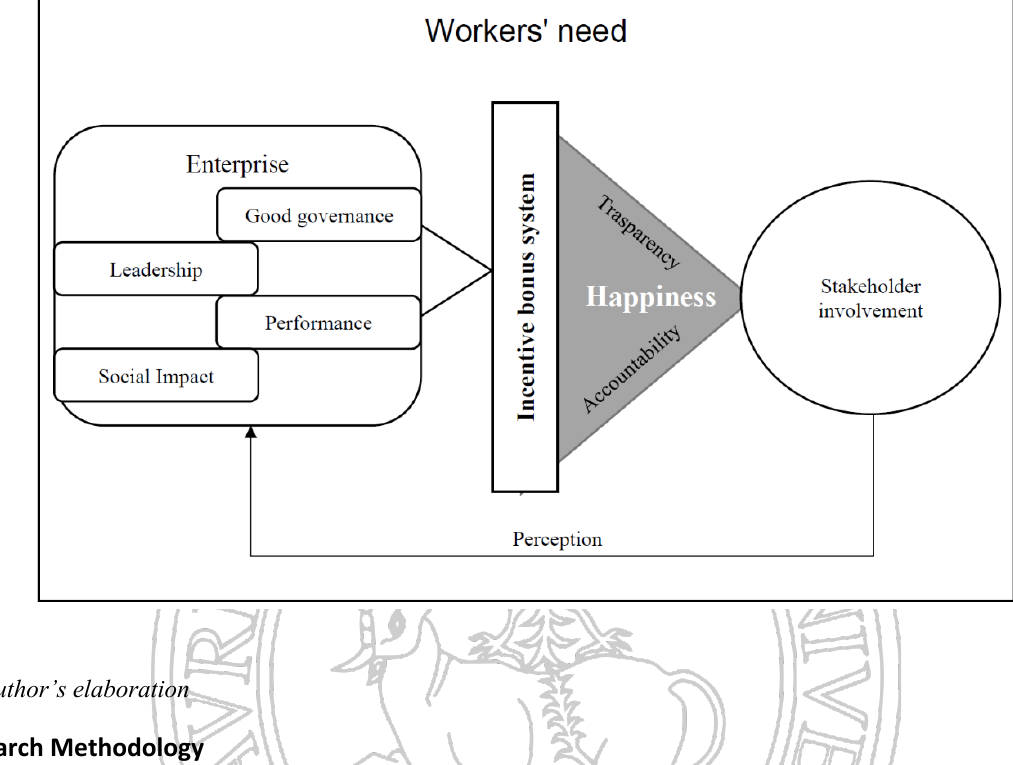
Figure 3. Model to satisfy Workers’